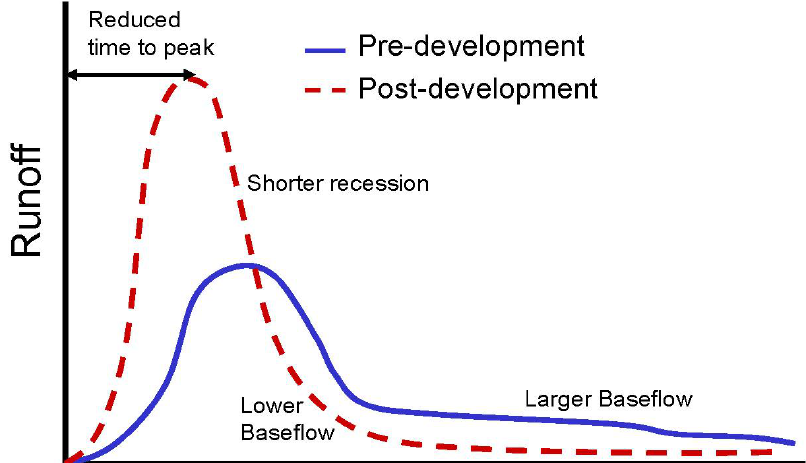
Figure 1. Schematic illustration of the pertinent impacts of urbanization on hydrology at the catchment